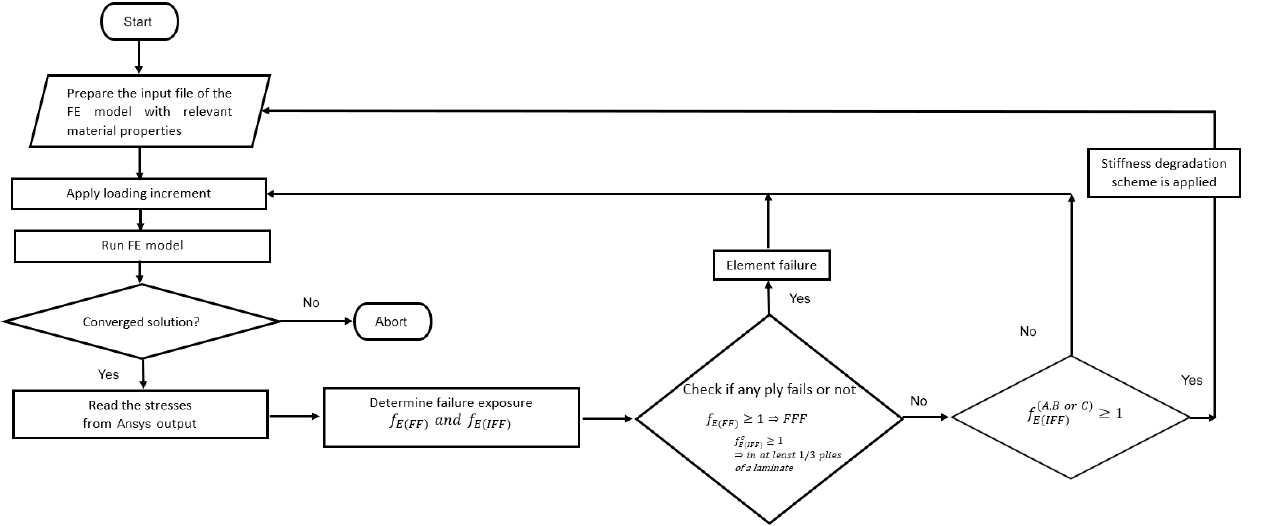
Figure 3. Flowchart of the FE-analysis-based strength analysis of a composite laminate using Puck’s damage